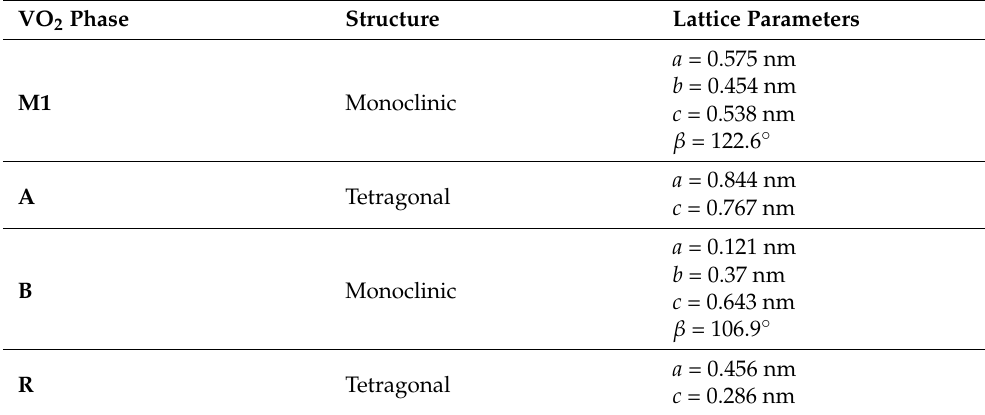
Figure 1. ( a ) TEM image of S1 VO 2 thin film on LSAT substrate, showing the general morphology; ( b ) SAD pattern from the interface area between VO 2 and the substrate. Table 1. Structural parameters of the various VO 2 polymorphs found in the thin